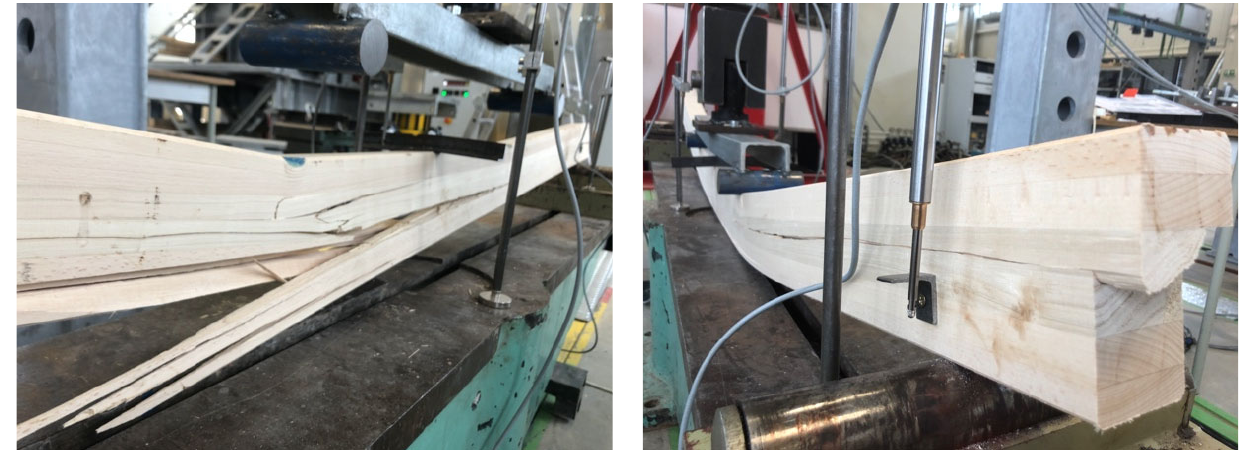
Figure 9. Examples of failure of the hybrid beech–poplar beam (BE-PO (hyb)) (authors’ archive).